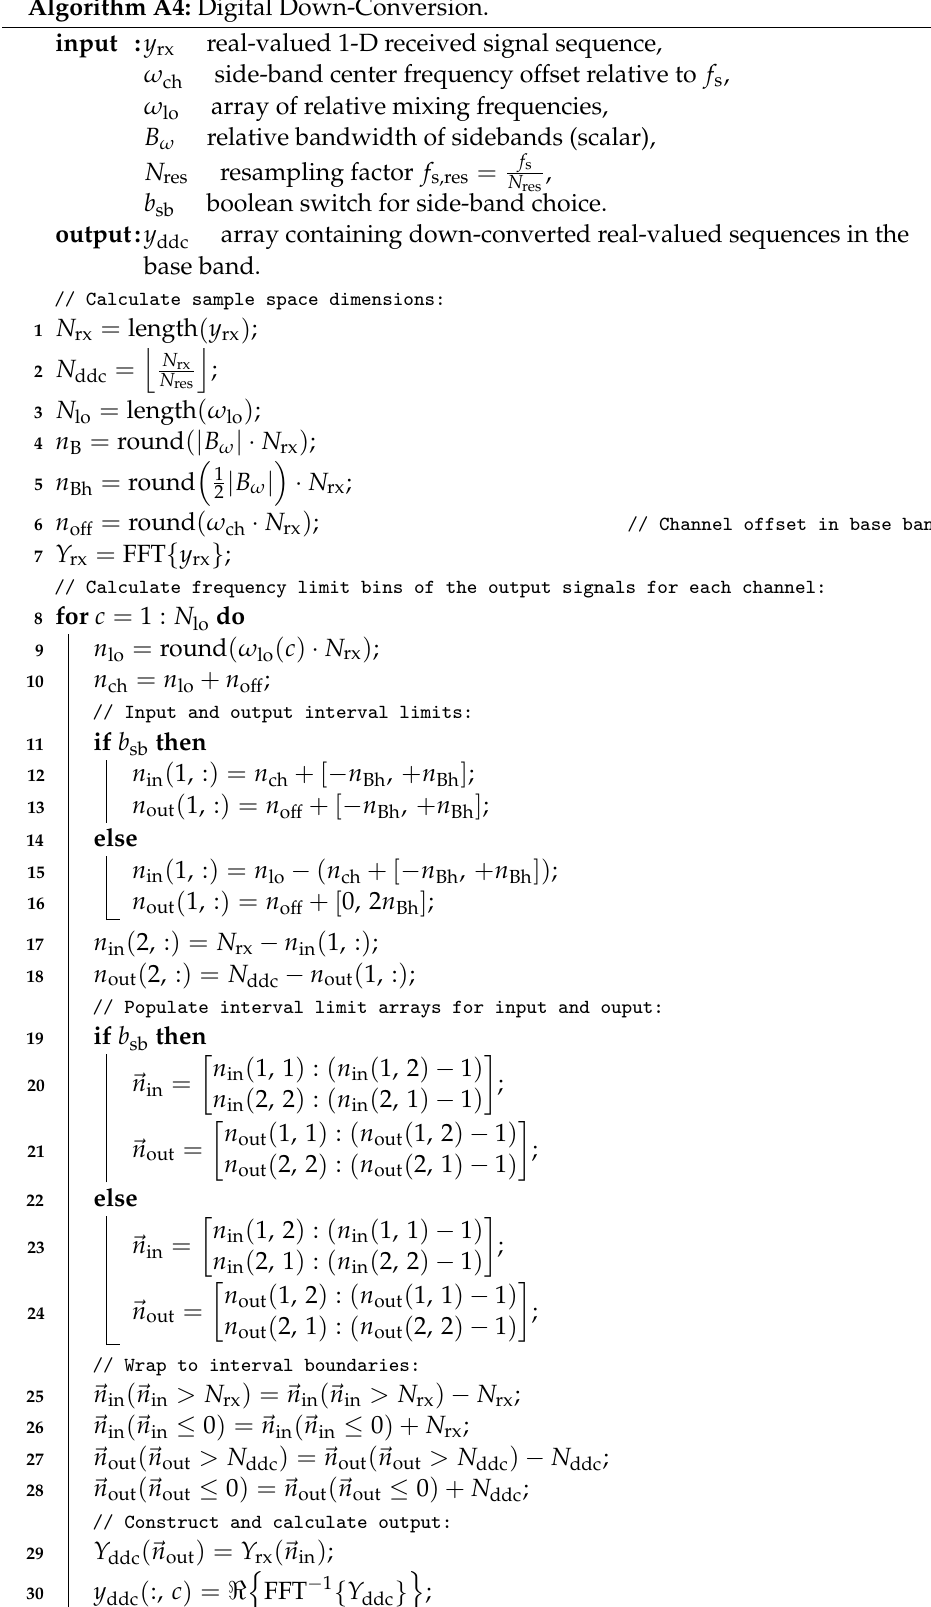
Algorithm A4: Digital